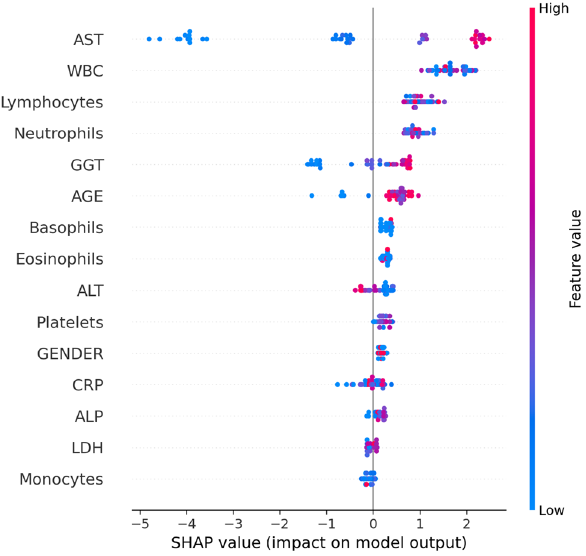
Figure 3. SHAP summary plot for a LightGBM classifier in the DF-COVID-19